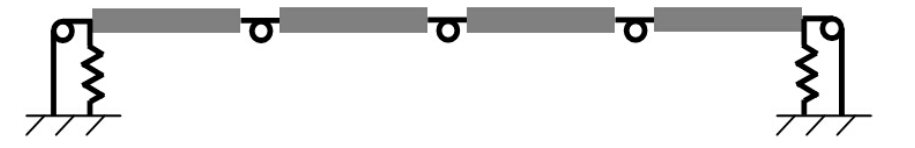
Figure 2. Analytical model of n -crack beam with n being 3.